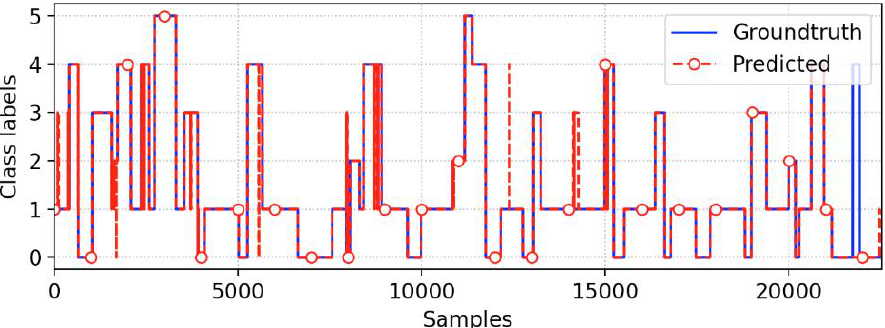
Figure 7. Expanded samples and labels in time series to verify the accuracy of the model applied to real-time detection.